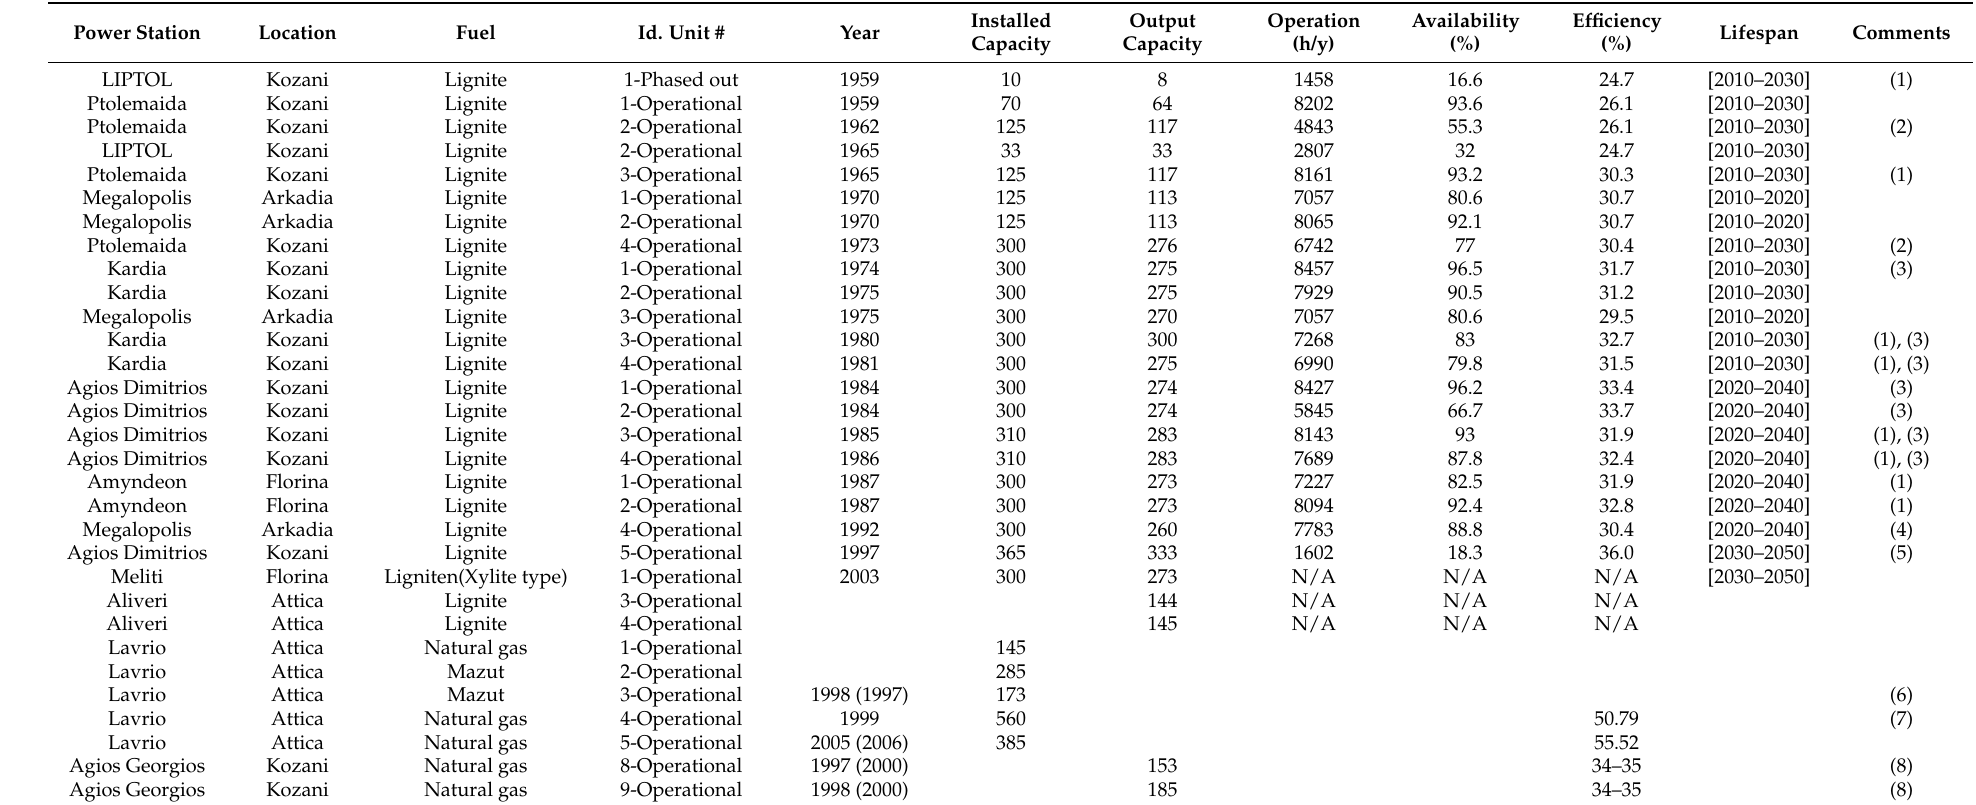
Table 4. Thermal power stations in Greece and their operational characteristics (interconnected